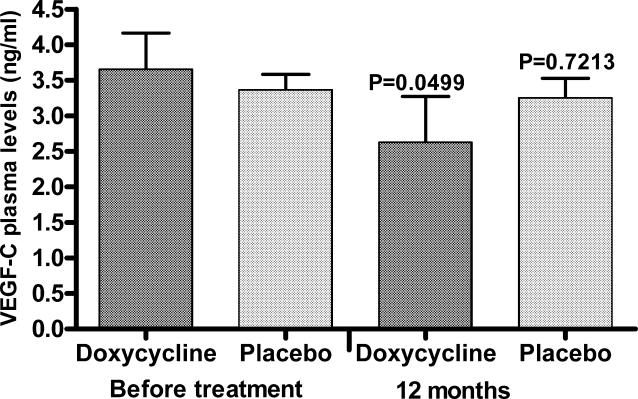
Plasma Levels of VEGF-C of Lymphedema Patients before and 12 Mo after Doxycycline TreatmentPlasma concentrations (mean ± SD) of VEGF-C were measured from plasma of lymphedema patients before and 12 mo after doxycycline treatment. The VEGF-C levels decreased significantly at 12 mo in the doxycycline-treated patients (p = 0.0499), in contrast to the placebo group (paired t-test).